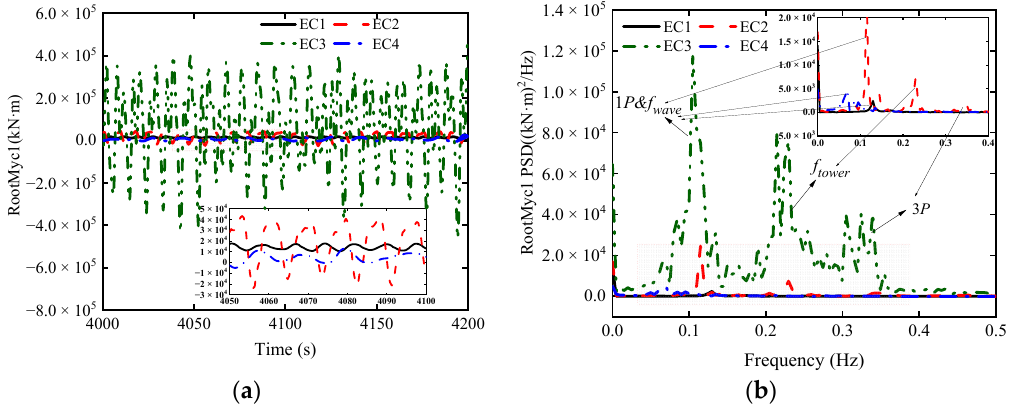
Figure 11. Time histories and spectra of the RootMyc1 under real environmental conditions: ( a ) Time histories of the RootMyc1; ( b ) Spectra of the RootMyc1.